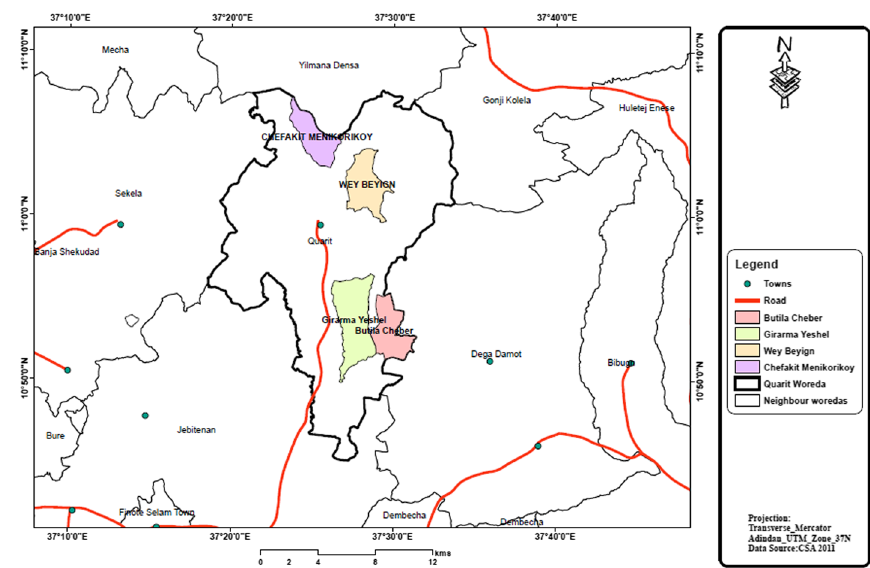
Fig. 1 Map of the study district and kebeles. Source : CSA